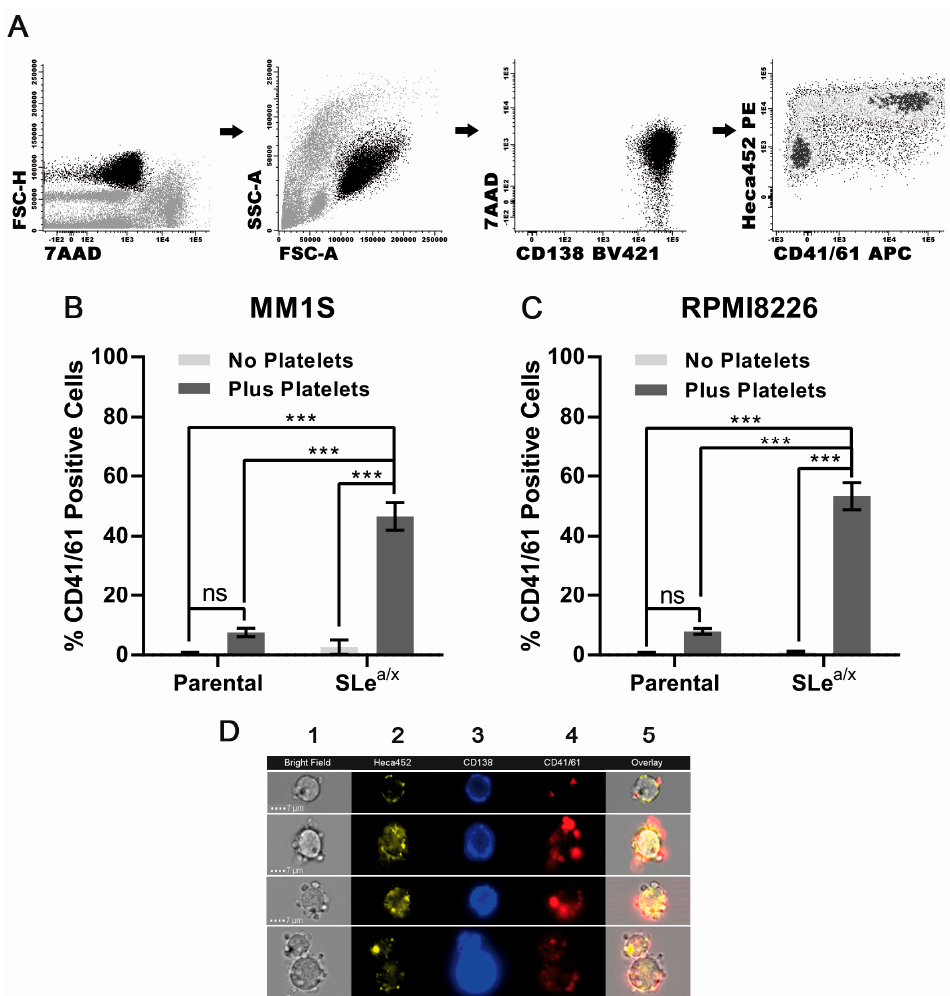
Figure 2. Interaction between MM cells is dependent on the expression of SLe a/x . ( A ) The gating strategy was employed to monitor CD41/61-positive cells in CD138-positive MM cells. Dead cells were excluded using the 7-aminoactinomycin D (7AAD). Parental and SLe a/x -enriched MM1S ( B ) and RPMI8226 ( C ) cells were co-cultured with/without platelets (platelet:MM ratio 1:100) isolated from the peripheral blood (PB) of healthy donors for 30 min, washed, stained and analyzed by flow cytometry. ( D ) Representative images from the ImageStream analysis of SLe a/x -enriched MM1S cells co-cultured with platelets as above. Numbers on the top of the images indicate the following: 1 Bright Field; 2 HECA452; 3 CD138; 4 CD41/41; 5 Overlay. Bar represents 7 µ m. Bars represent the mean ± sem of at least three independent experiments. Statistical analysis was performed using two-way ANOVA and Sidak’s multiple comparison test. *** p < 0.001; ns